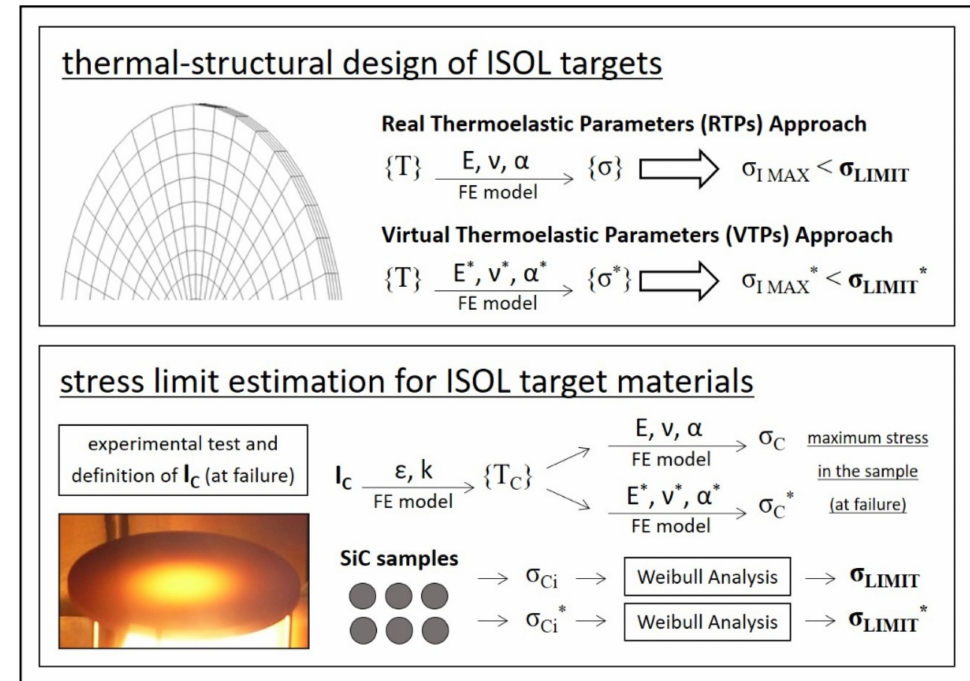
Figure 7. Thermal–structural design of ISOL targets making use of the RTPs and VTPs approaches.